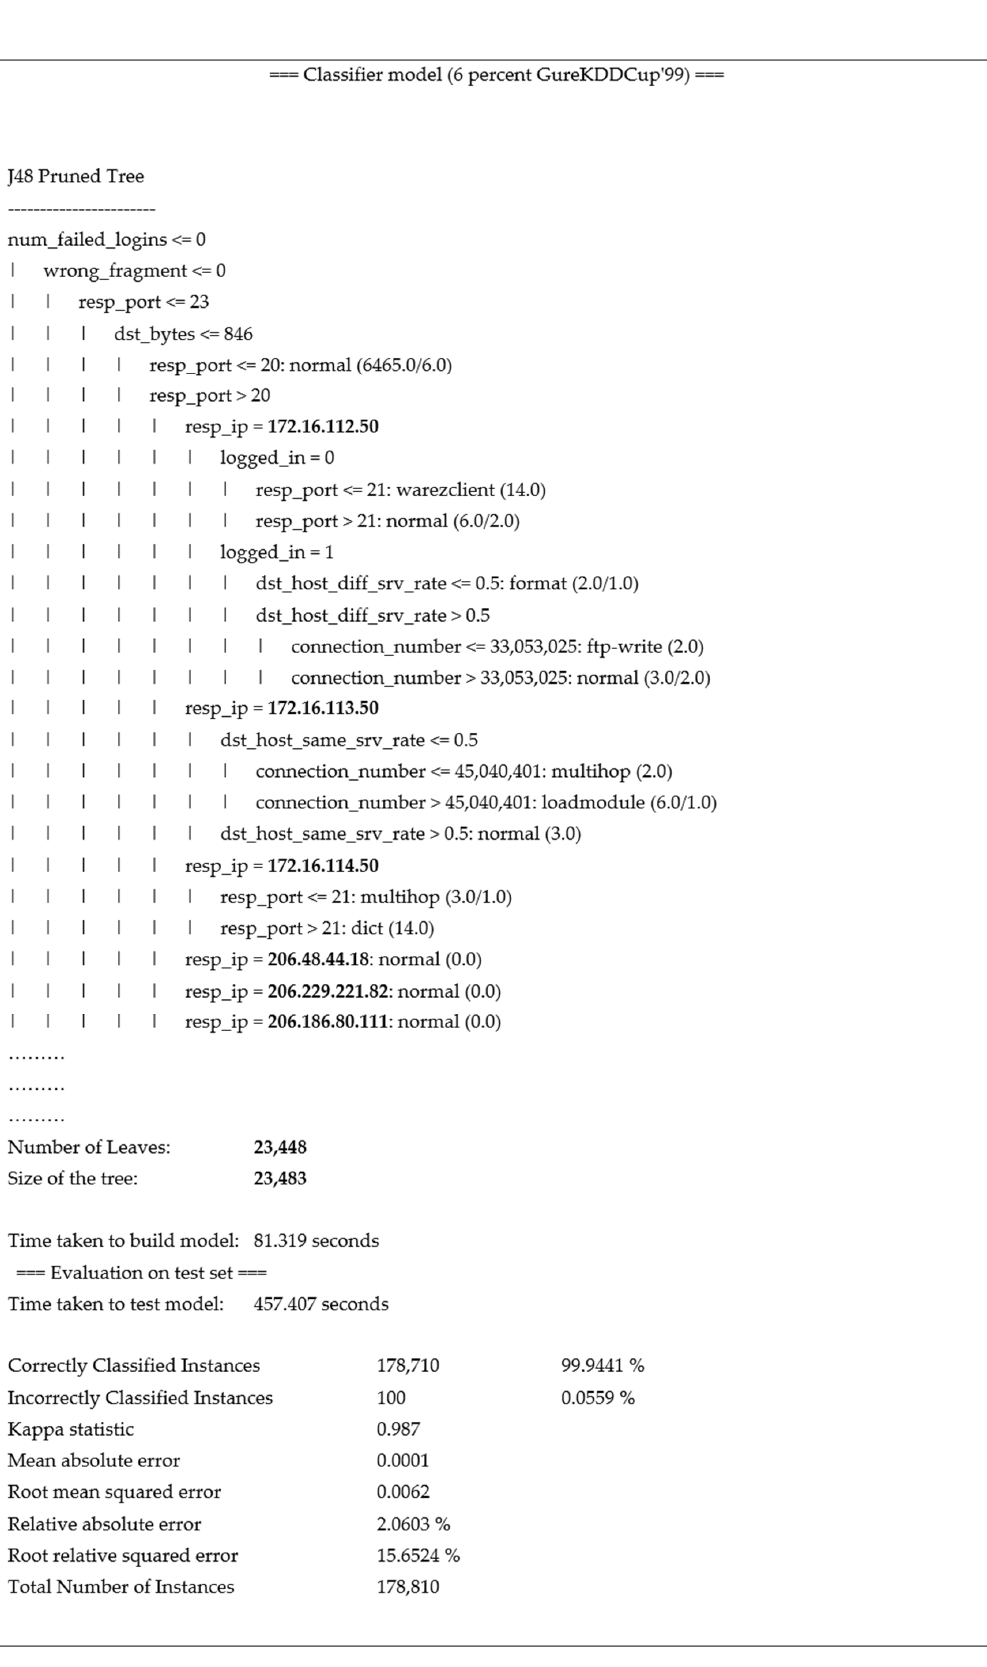
Figure 1. ASCII J48 (Weka implementation of C4.5) Pruned Tree Model (partial), Performance Result on 6 Percent ‐ GureKDDCup’99 (Original).